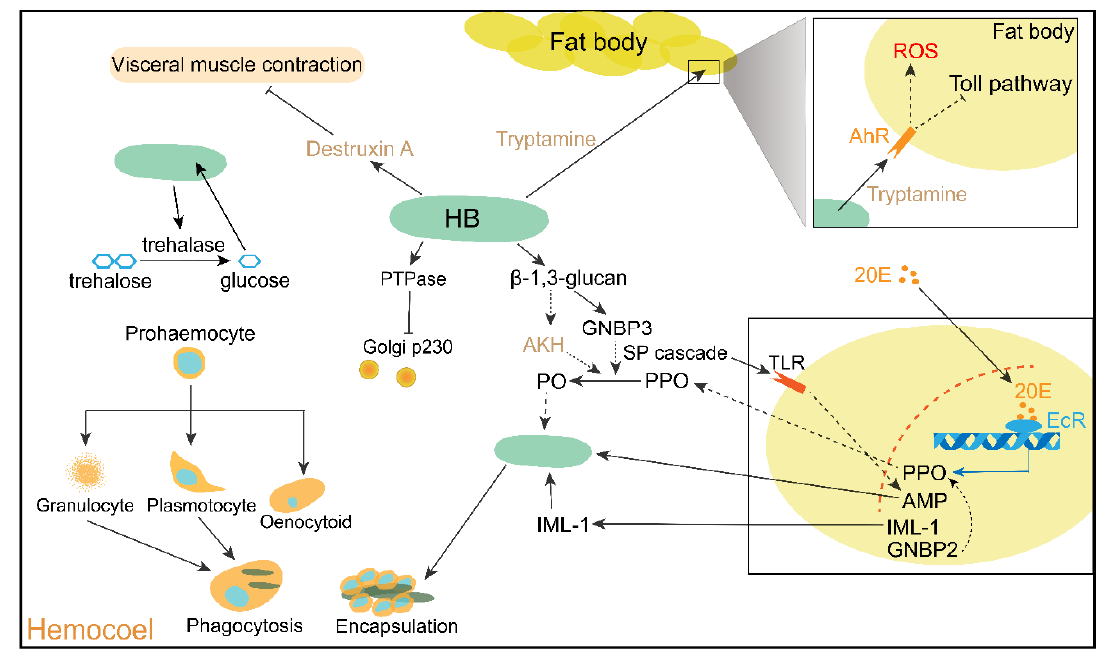
Figure 3. The late-phase interactions between Metarhizium spp. and locusts. The growth of the yeast-like hyphal bodies (HB) in the hemolymph of locusts relies on the ingestion of the locusts’ nutrients. The secreted protein and metabolites from Metarhizium to restrain humoral and cellular immunity. The pathways of ecdysone and Toll are opposed to the growth of HB. The dotted arrows or T represent indirect actions to promote or inhibit another component. The solid arrows or T indicate direct promotion or restraint to another component. 20E, 20-Hydroxyecdysone; EcR, ecdysone receptor; TLR, Toll-like receptor; IML-1, immunlectin-1; GNBP3, Gram-negative bacteria binding protein 3; AhR, aryl hydrocarbon receptor; SP, serine protease; Serpin, serine protease inhibitor; ROS, reactive oxygen species; PPO, prophenoloxidase; PO, phenoloxidase; AMP, antimicrobial peptides; PTPase, protein tyrosine phosphatase.